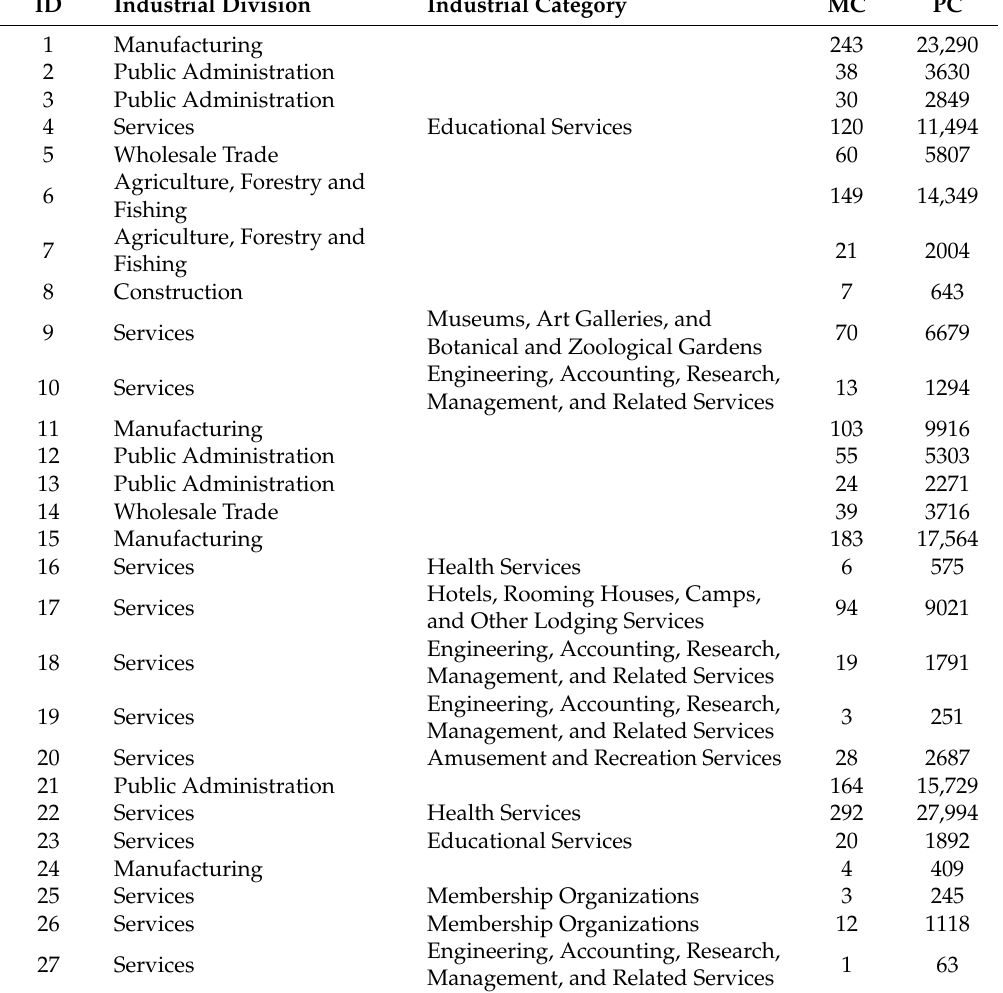
Table A1. Mean power consumption (MC) and the mean of the daily power consumption